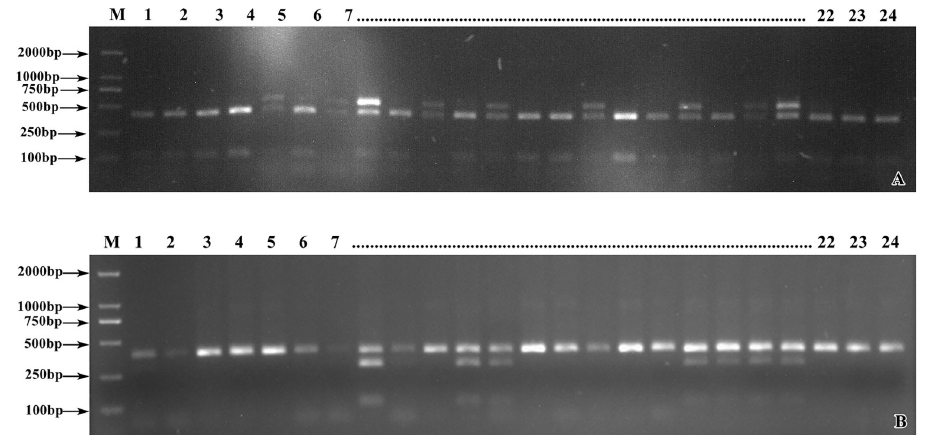
Fig 5. Partial results of enzyme digestion chr2-CAPS6 andchr2-CAPS21 markers for F 2 population. (A) chr2-CAPS6 enzyme digestion electrophoresis. (B) chr2-CAPS21 enzyme digestion electrophoresis. M. DL2000 Marker; 1~24. F 2 individuals.